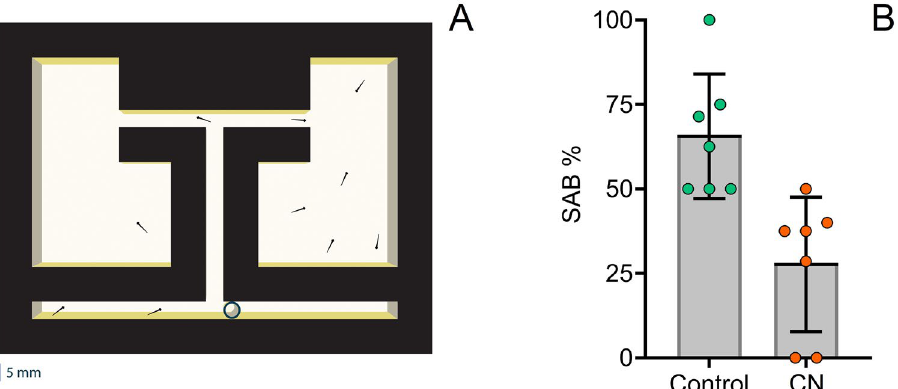
Figure 5. ( A ) Spontaneous Alternation Behaviour (SAB) assay with bottom illumination to test exploratory swimming and spatial memory. The starting arms can be used alternatively (a plastic tube blocks the entrance to the opposite arm) and converge into a perpendicular main arm that leads to a choice of alternation or same side arm. These arms lead to distinct pools of 19.50 mm 2 . ( B ) Comparison of SAB in 5 dpf under continuous noise at 150 dBre 1 μPa (CN) and control conditions (t (113) = − 4.08, p < 0.001). From a total of 180 tested larvae, 115 successfully showed alternation behavior (entered the opposite side pool) within the 10-min recording. Individual data are presented as scatter plots and bars depict mean ± 95% confidence intervals. Illustration was created using Adobe Illustrator CC 2020 version 24.0.2 for Windows, Adobe Inc., CA, USA and Blender version 2.80 for Windows, Blender Foundation, AMS,